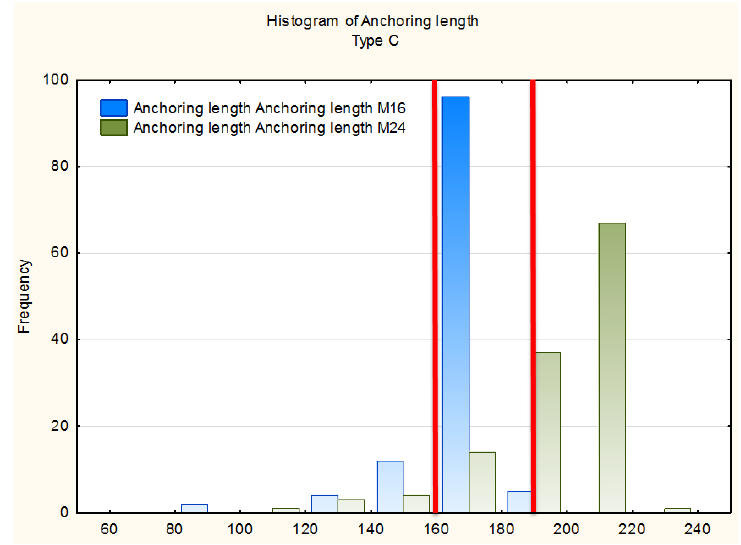
Figure 6. Histogram of anchoring length—type C.